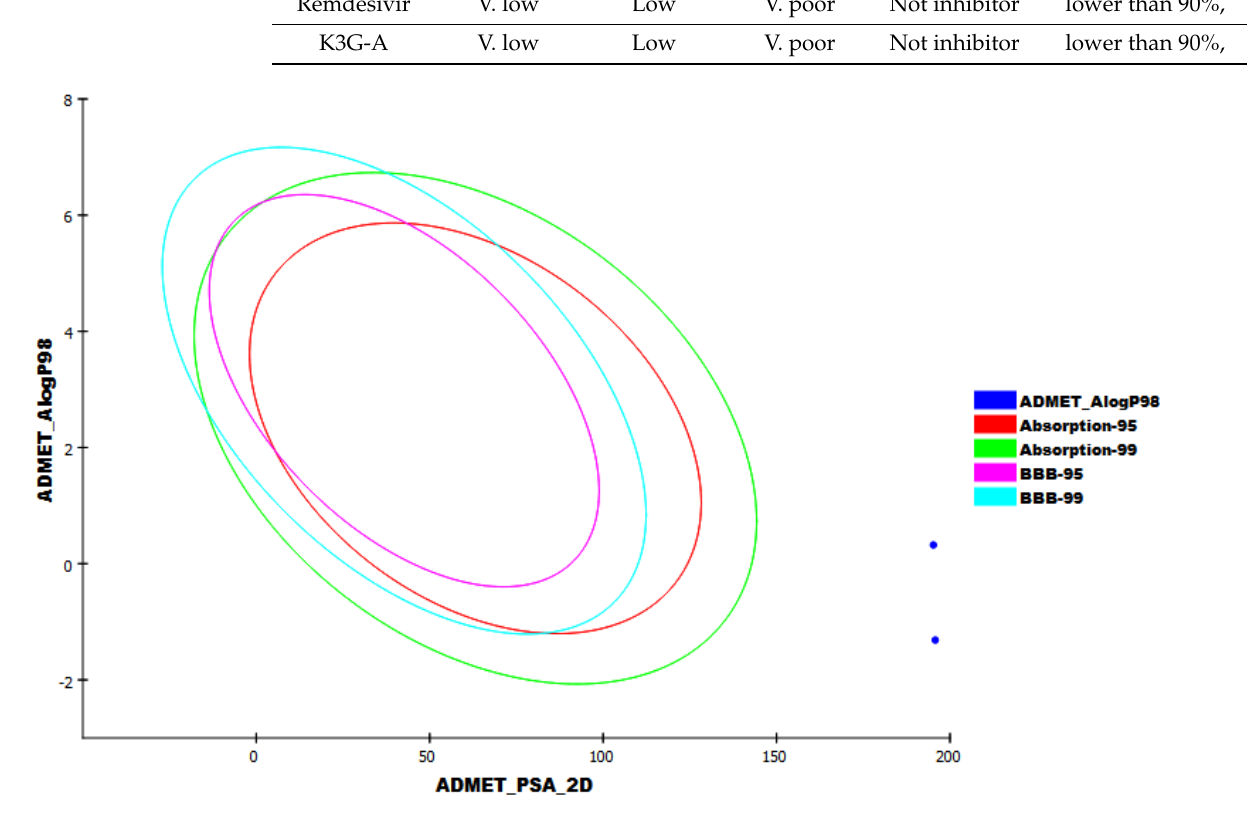
Figure 8. The ADMET study of K3G-A and remdesivir. Table 4. Predicted ADMET for K3G-A and remdesivir.